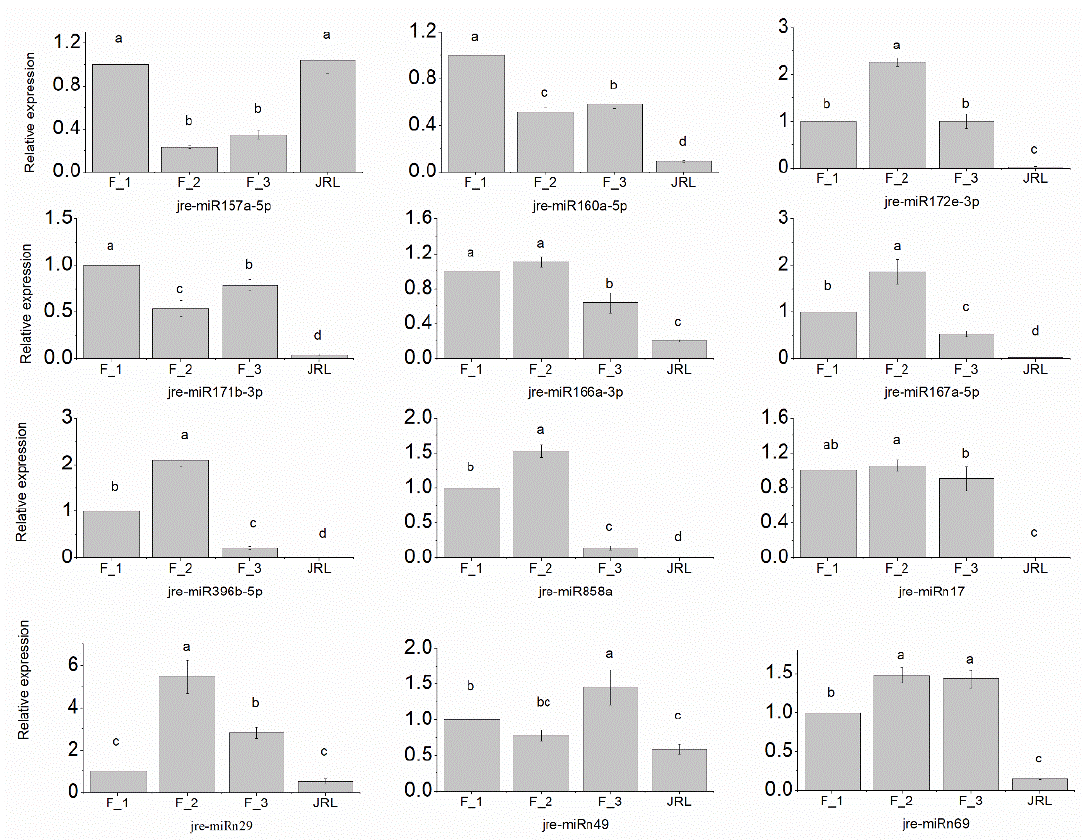
Figure 4. Relative expressions of 12 of the most promising miRNAs as determined by RT-qPCR. Each value is the average of three biological and technical repetitions. The error bars represent standard deviations. Values with different letters are significantly different according to Duncan’s multiple range test ( p < 0.05).